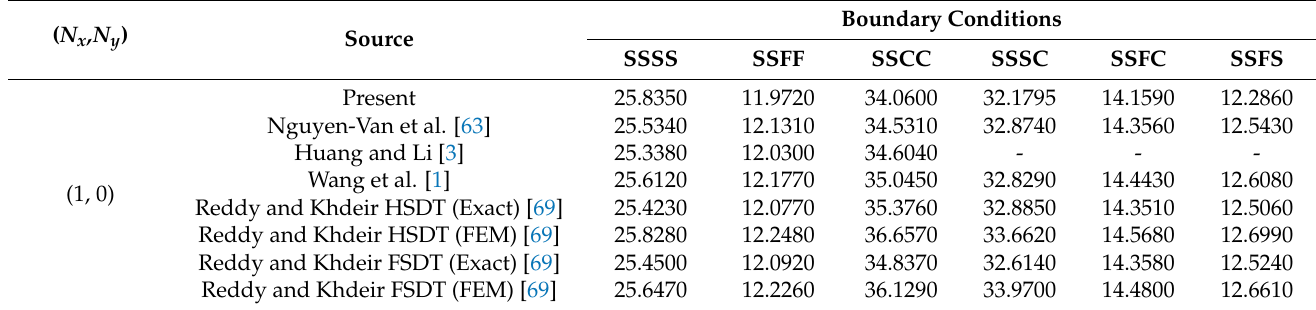
Table 6. Comparison of nondimensional buckling loads, 2 3 gular plates with various mixed boundaries subjected to uniaxial compressions ( E 1 / E 2 = 40, α /h = 10, G 12 = G 13 = 0.6 E 2 , G 23 = 0.5 E 2 , υ 12 = 0.25, α /b = 1).